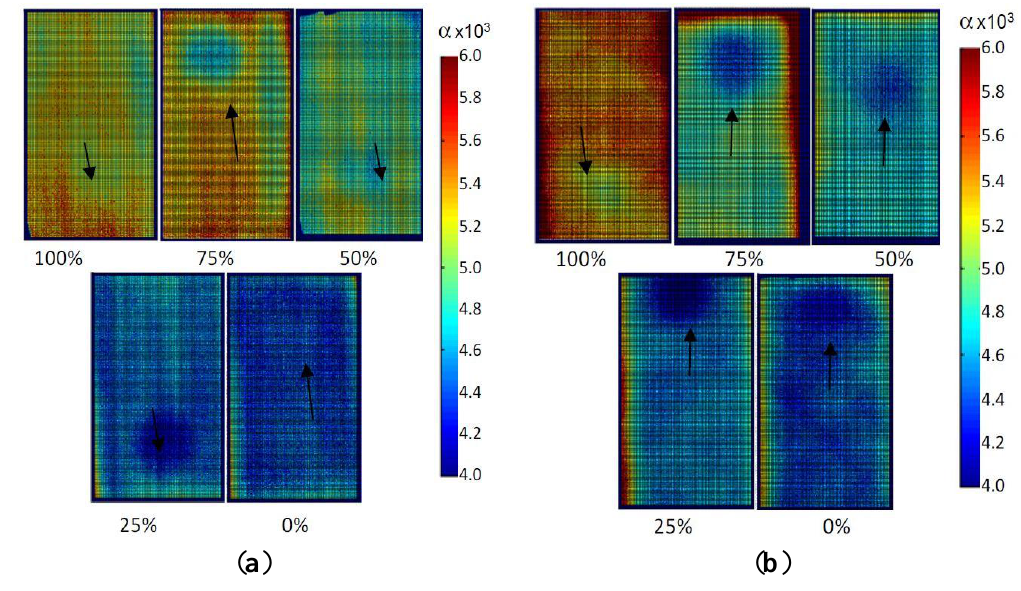
Figure 8. Normalized average thermal diffusivity,